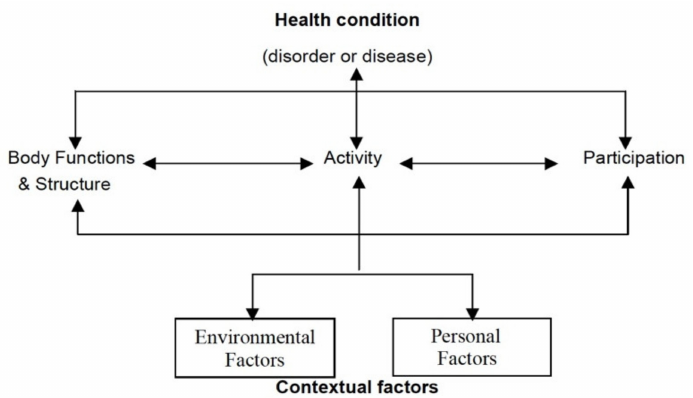
Figure 1. International Classification of Functioning, Disability, and Health (ICF) model of the World Health Organization